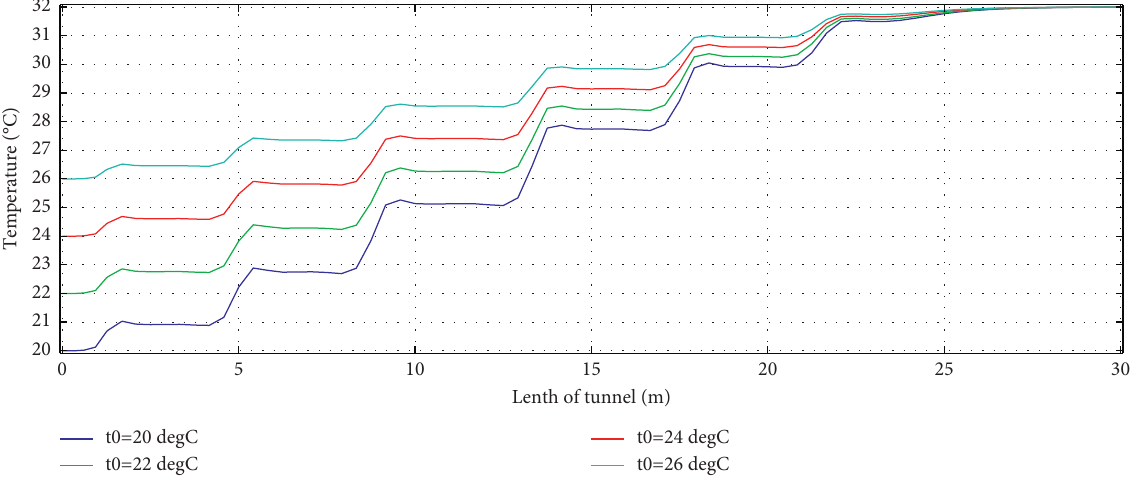
Figure 14: Air temperature distribution inside the tunnel at different air temperatures.